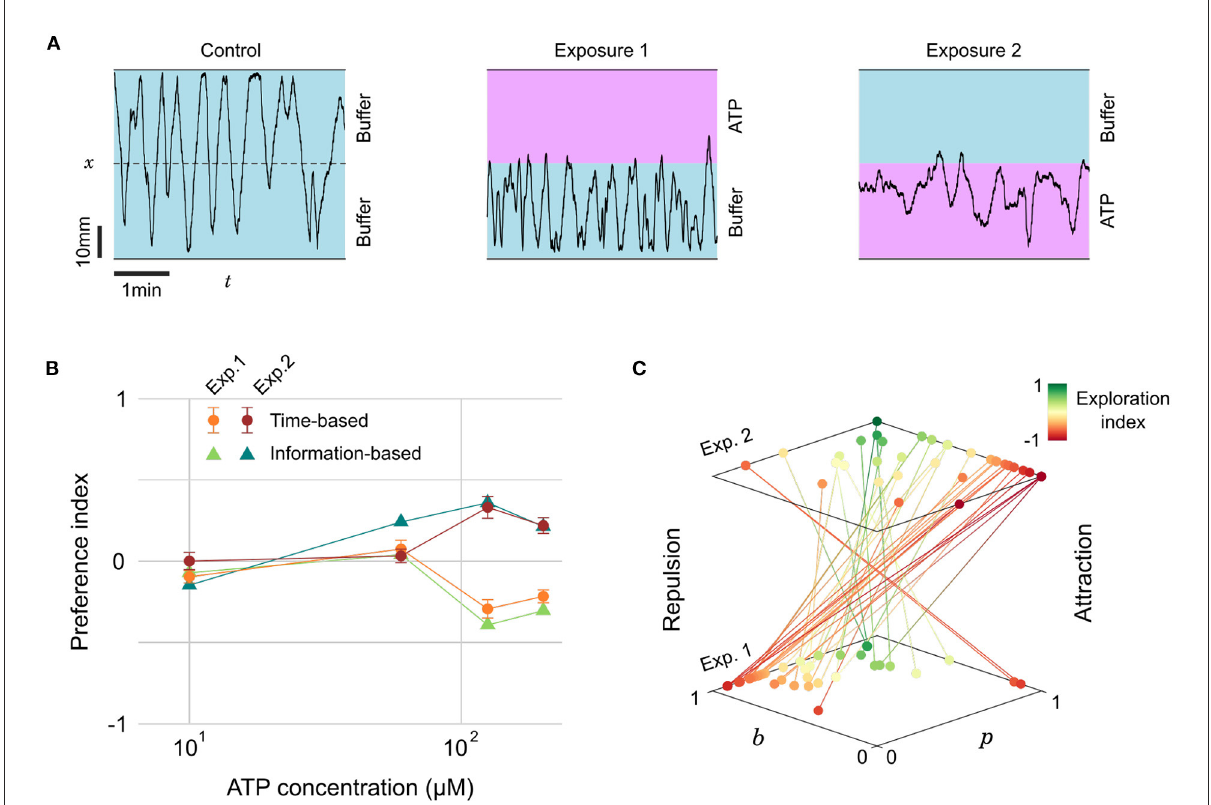
FIGURE5 Evolving preference for ATP during successive exposures. (A) Blow-ups of lateral traces ( x -position vs. time) of the same 22 dpf zebrafish during control and two successive exposures to ATP (200 µ M ) on alternating sides. (B) Preference index as a function of ATP concentration for two successive exposures, defined either by the residence times or by the transition statistics ( n 28, 12, 18, and 22 fish for increasing = concentrations). (C) Transition probabilities ( p , b ) for all fish during the successive exposures to the two highest concentrations of ATP. Color encodes the exploration index, n 40 =